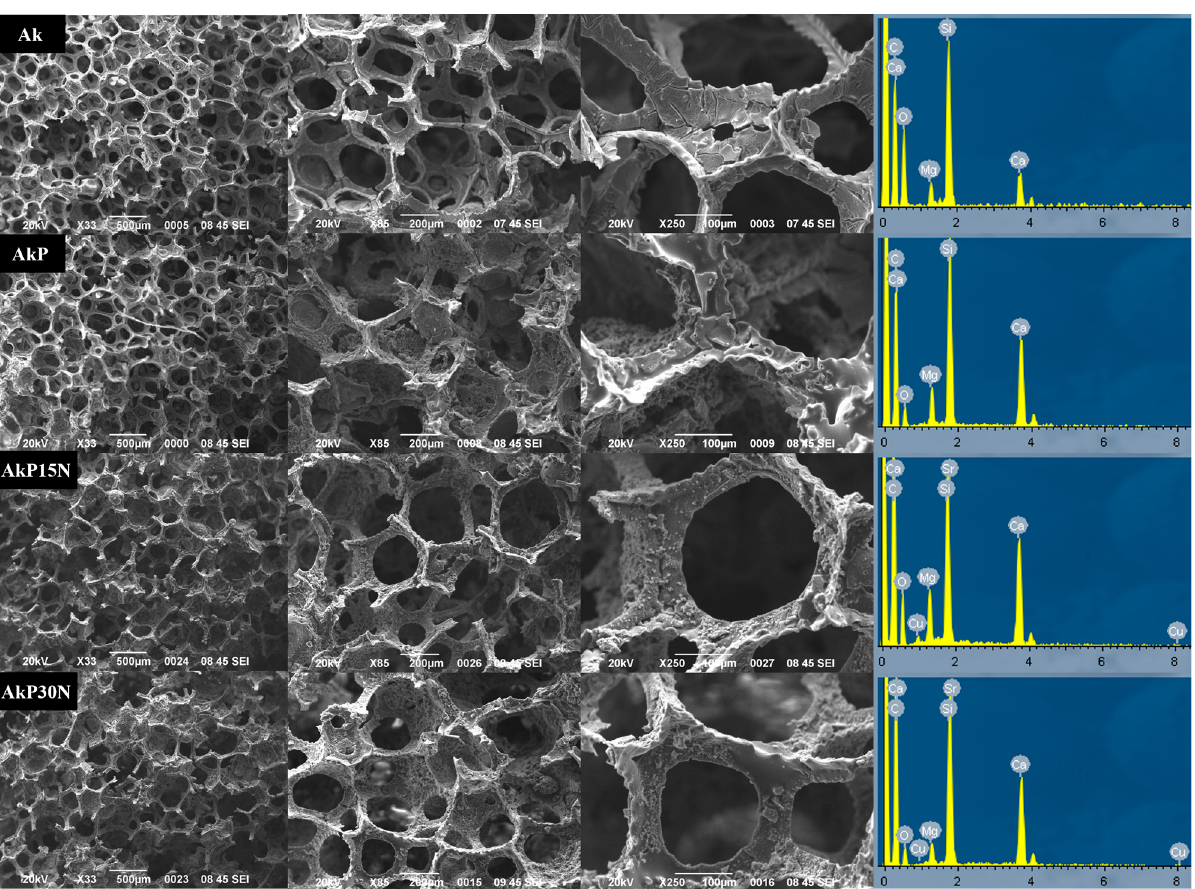
Figure 13. SEM micrographs and the EDS spectra of all types of scaffolds.